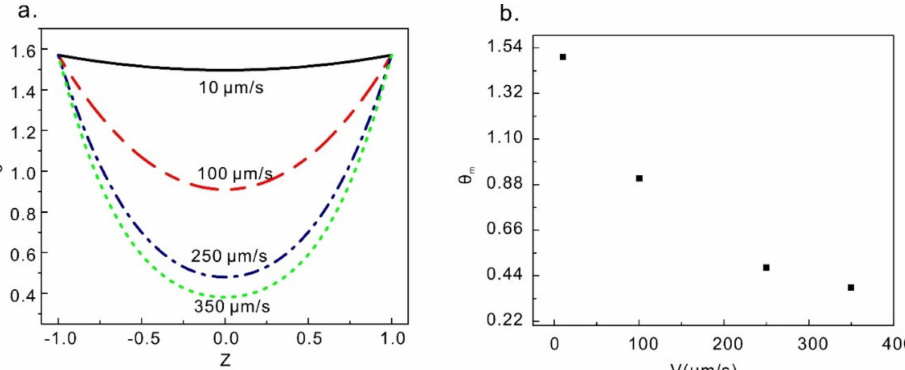
Figure 4. ( a ) Director profiles at different velocities of the upper plate. ( b ) The maximum directional angle at different velocities of the upper plate.